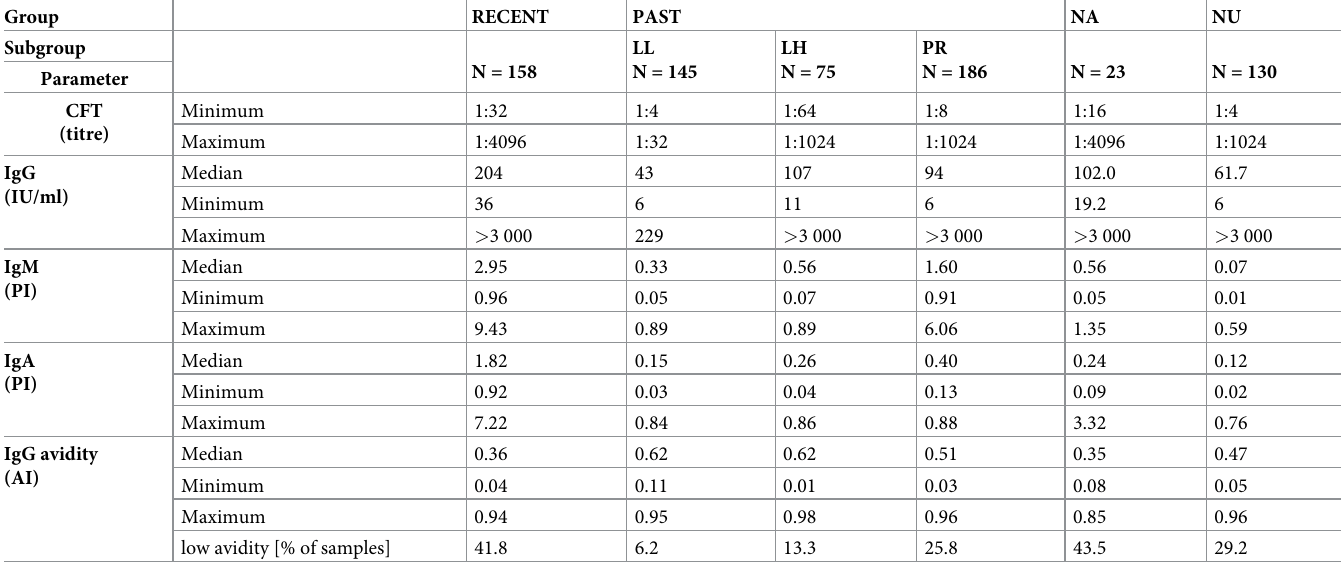
Table 1. Serological parameters of 717 samples categorised in six groups and subgroups according to the toxoplasmosis status.